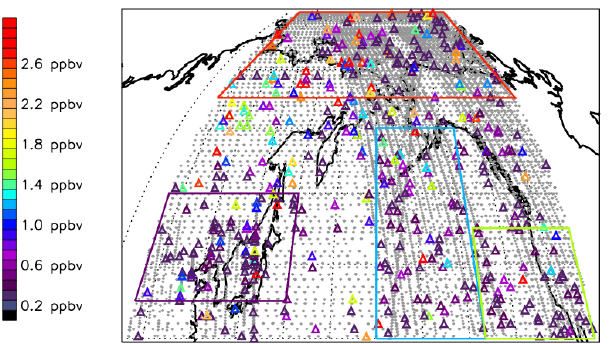
Figure 10. Gray points show all TES observations over the northern Pacific and surrounding land masses for April 2008. Colored triangles show points where elevated PAN was detected in the TES spectra with some confidence (DOFS > 0.6). The VMR values represent the average over all points in the profile where the sum of the row of the averaging kernel is greater than 0.5. Colored latitude/longitude boxes highlight the regions associated with the histograms in Figure 11.